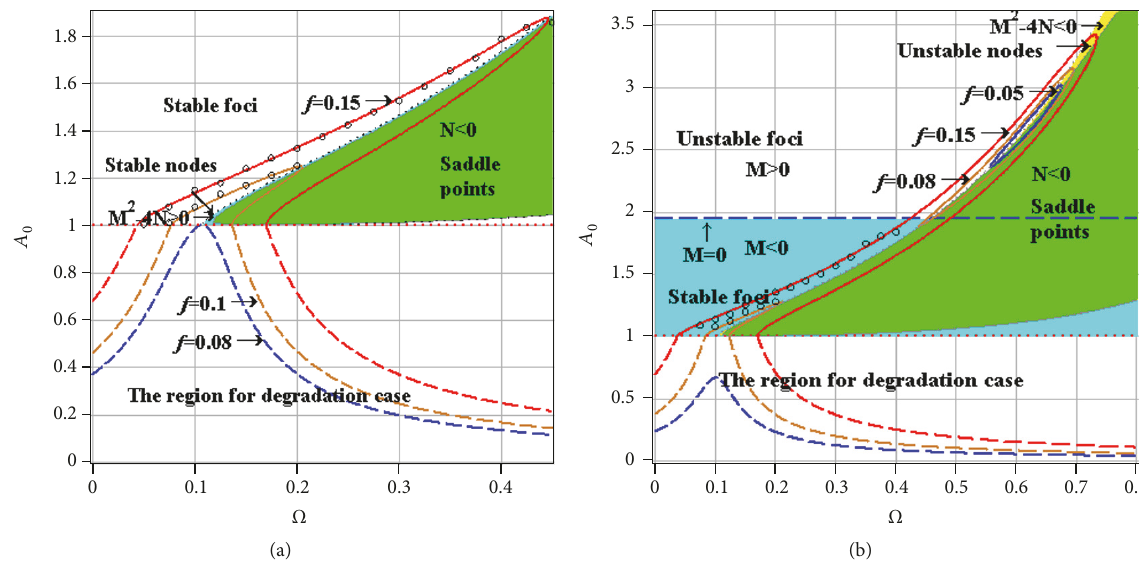
Figure 3: Comparison of frequency responses under different external excitation amplitudes. Solid lines: the curves of frequency responses; dash lines: the curves of degradation frequency responses. Circles present the numerical results. (a) 𝜏 = 𝜋/2 ; (b) 𝜏 = 3𝜋/4